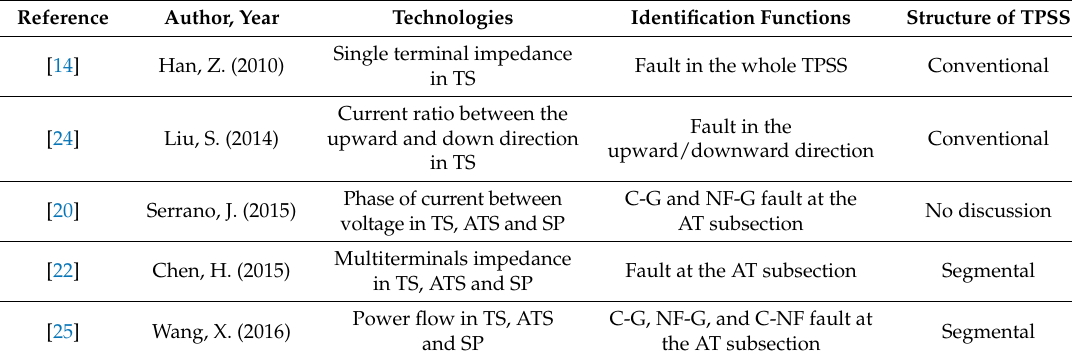
Table 1. Publications on protection schemes of all parallel AT